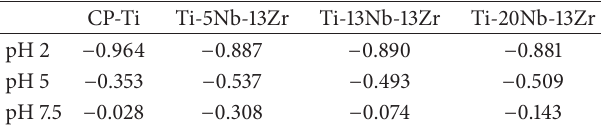
Table 2: OCP values (in V/SCE) measured after 3h exposure in Ringer’s solution of pH 2, 5, and 7.5 containing 1000ppmF at 37 ∘ C.